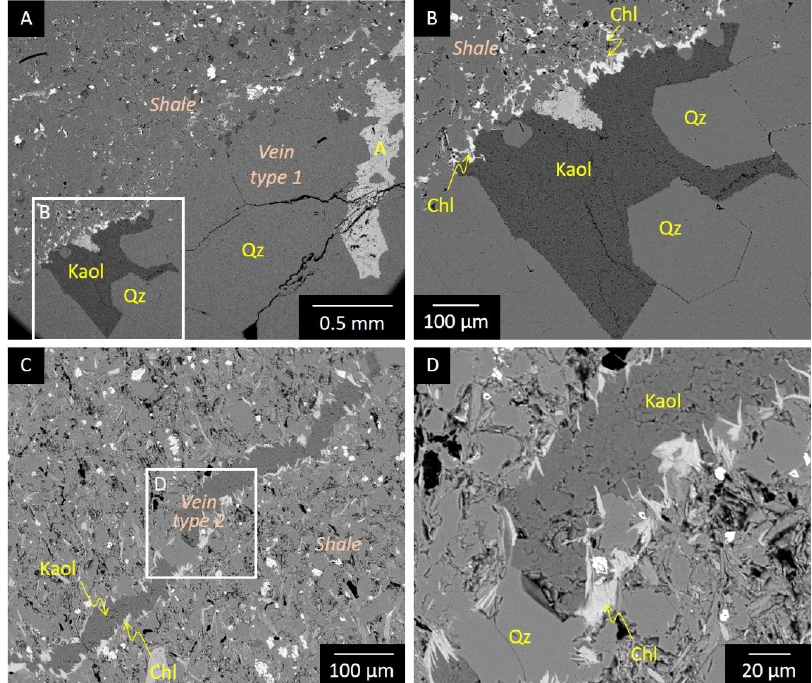
Figure 5. SEM images (backscattered-electrons) of a vein/shale contact (vein type 1). ( A ): large view of a vein/shale contact, showing the millimetric size of euhedral quartz in vein (type 1) and the absence of chlorite fringe at the quartz/shale interface. ( B ) image is located. ( B ): vein/shale contact, focused on the kaolinite/shale interface, underlining the presence of chlorite along this interface, and the occupation by kaolinite of the porosity left by quartz growth in the vein (type 1). ( C ): large view of a vein (type 2)/shale contact. ( D ) image is located. ( D ): vein/shale contact, focused on the start of the chloritization process, with sparse hairy chlorites which do not yet form a fringe. A: ankerite; Qz: quartz; Kaol: kaolinite; Chl: chlorite.